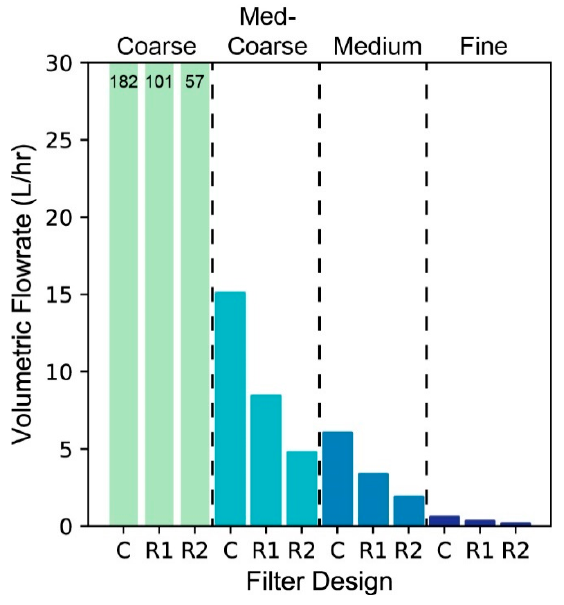
Figure 5. Modeled average volumetric flow rate by filter design (a traditional BSF design (C), a 40% reduced-height design (R1), and a 70% reduced-height design (R2)) for varying sand media.